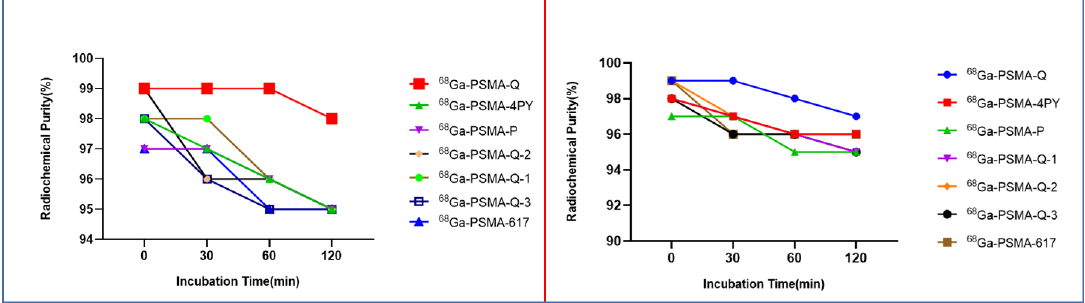
Figure 2. Stability of the novel tracers in PBS ( left ) and 5% BSA ( right ).